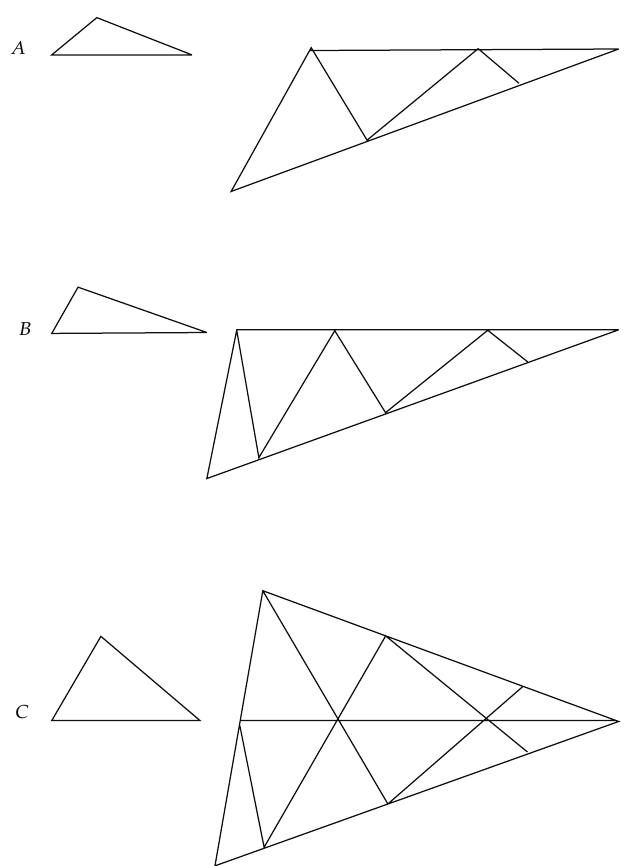
Figure 3: Inflation rules for the ninefold symmetry tiling.